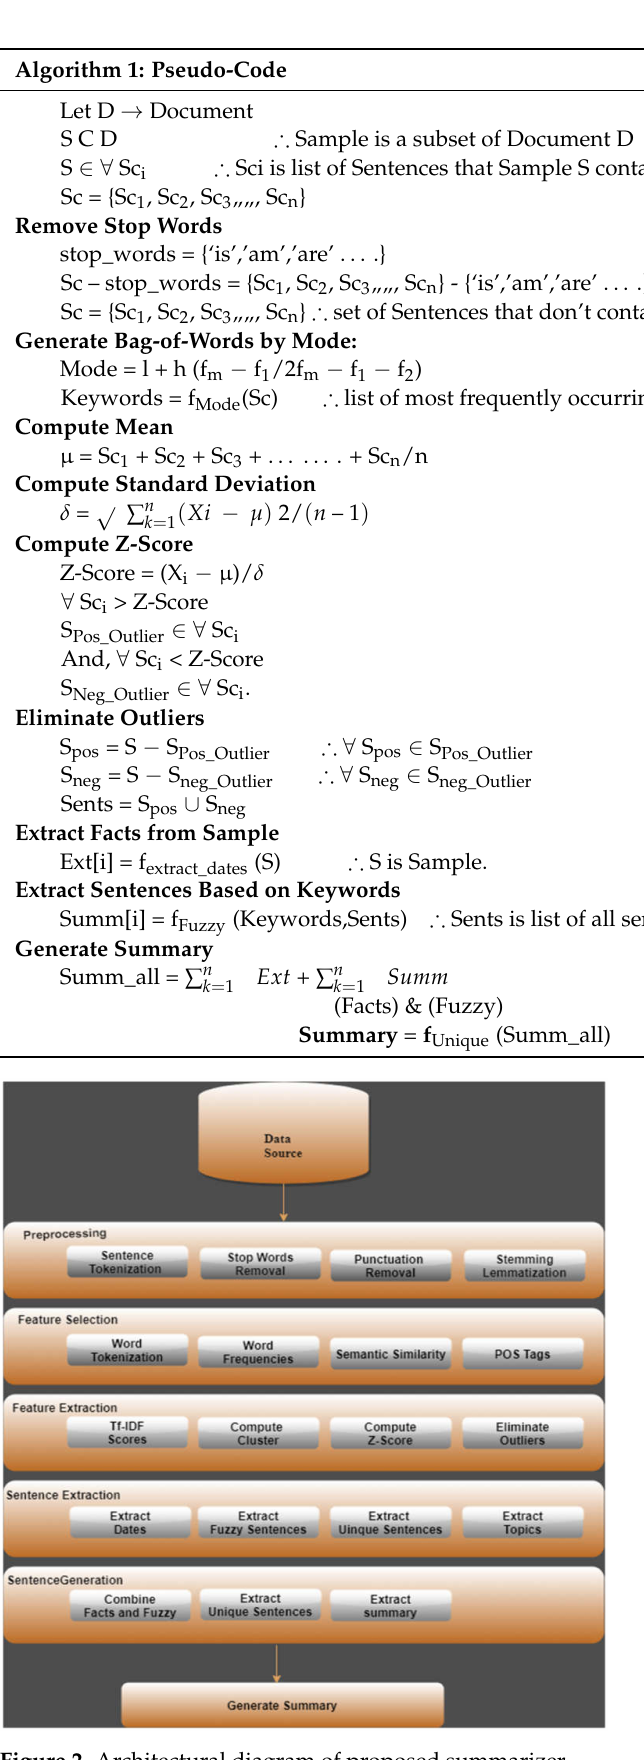
Figure 2. Architectural diagram of proposed